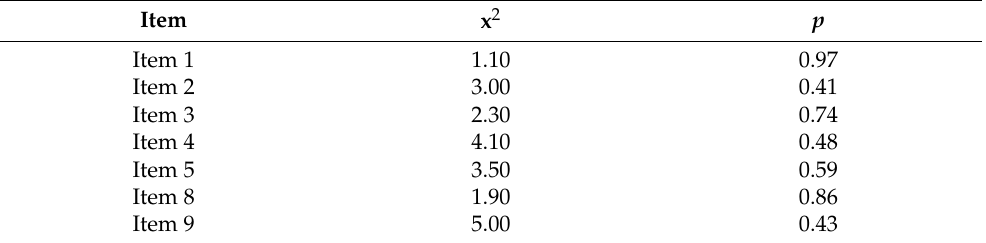
Table 6. Results of DIF